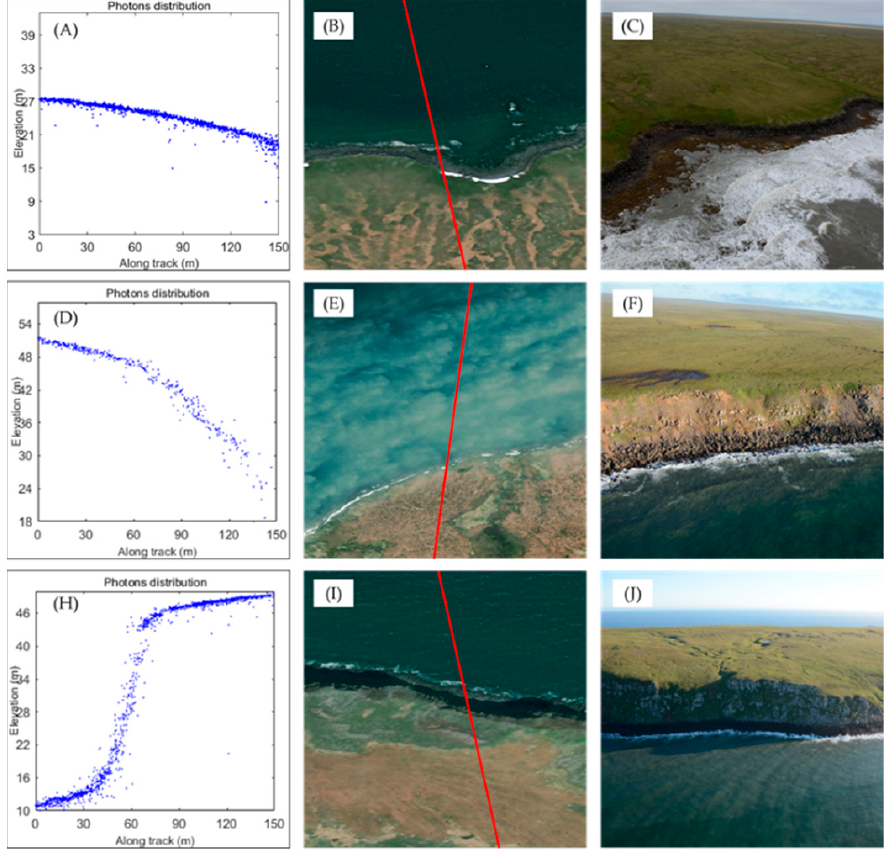
Figure 2. The typical coastline of Nunivak Island. Different coastal zones are represented in a row: (1) ( A – C ) are the platform with a gravel beach, (2) ( D – F ) are ramps with a gravel beach, and (3) ( H – J ) are cliffs with a gravel beach. The left column is photons distribution from ICESat-2, and the middle column represents a true-color image. The right column corresponds to digital images from ShoreZone classification. The red line corresponds to the ICESat-2 track.